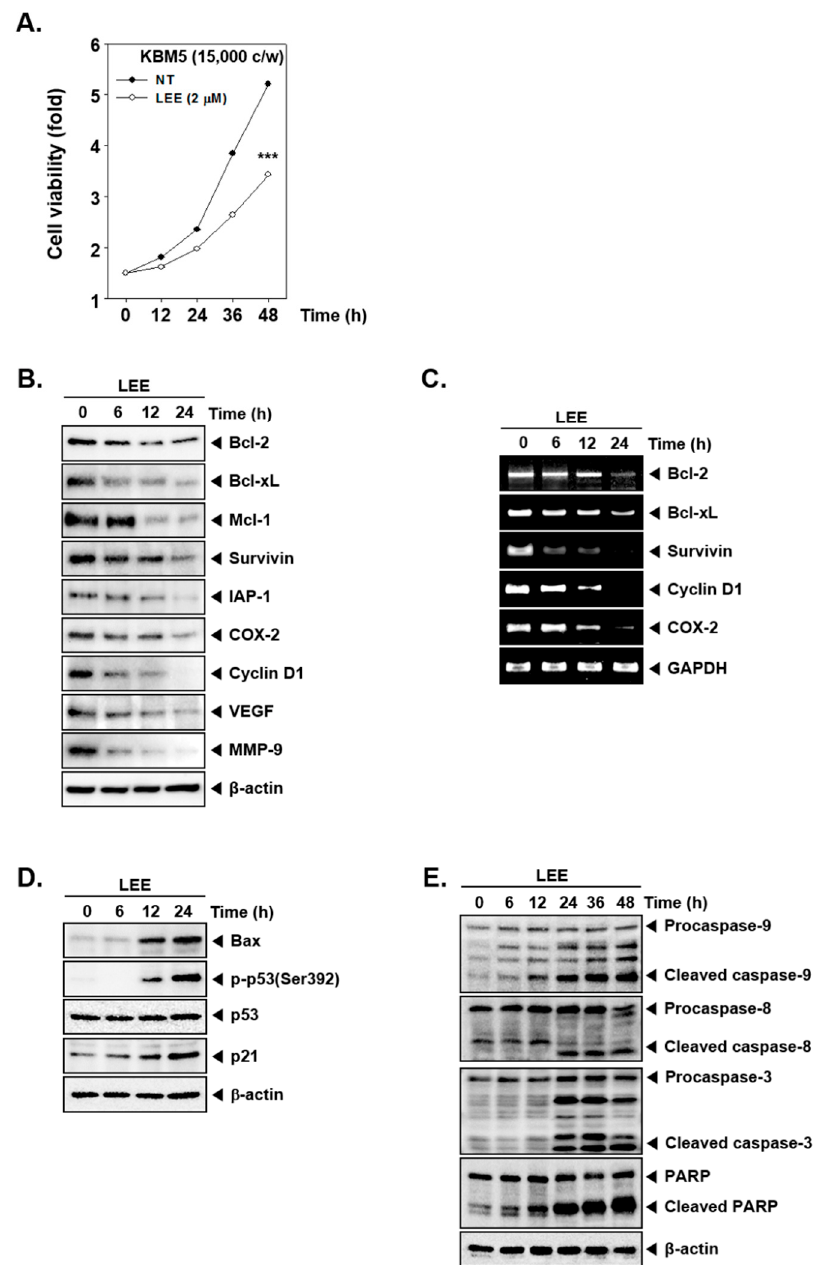
Figure 3. Analysis of levels of various proteins upon LEE treatment. ( A ) The effect on cell proliferation in KBM5 cells upon exposure to LEE. KBM5 cells (1.5 × 10 4 cells/well) were treated by 2 μ m of LEE for 12 h time intervals and MTT assay was performed. *** p < 0.001. ( B ) KBM5 cells were treated by LEE (2 μ m) for 0, 6, 12, and 24 h, and levels of various proteins were evaluated by Western blot analysis. ( C ) mRNA levels of selected genes were examined by RT-PCR. ( D ) LEE (2 μ m) treated KBM5 cells were evaluated for expression of various proteins by Western blot analysis. ( E ) KBM5 cells were treated with LEE (2 μ m), then apoptosis markers were evaluated by Western blot analysis.